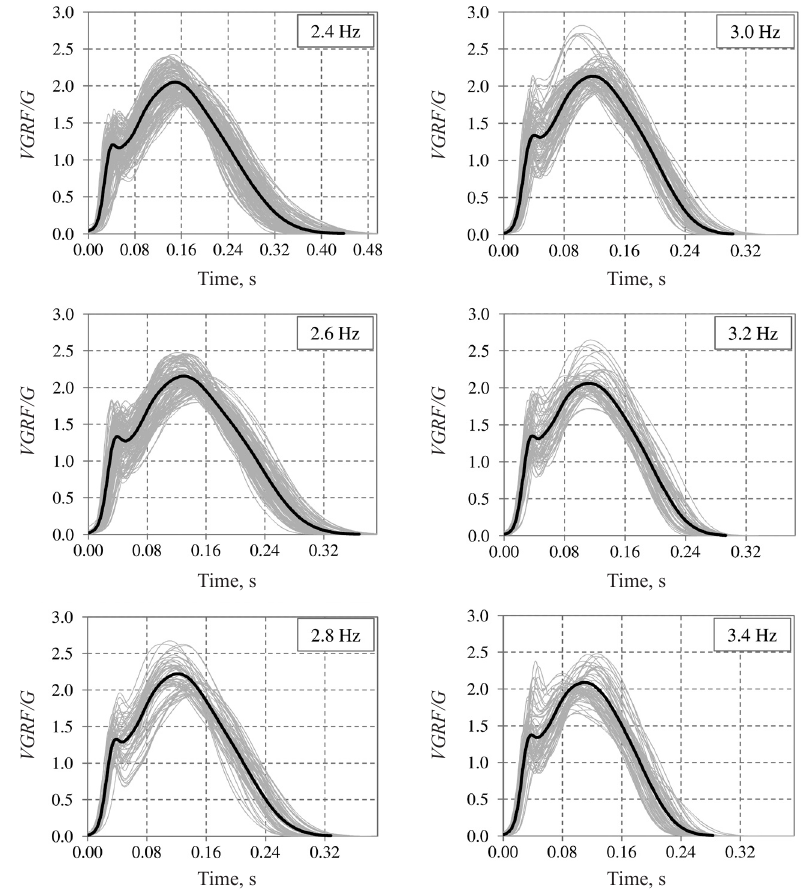
Figure 12. The templates (solid black line) determined for running frequencies of f r = 2.4–3.4 Hz with exemplary laboratory tests results (thin grey lines)